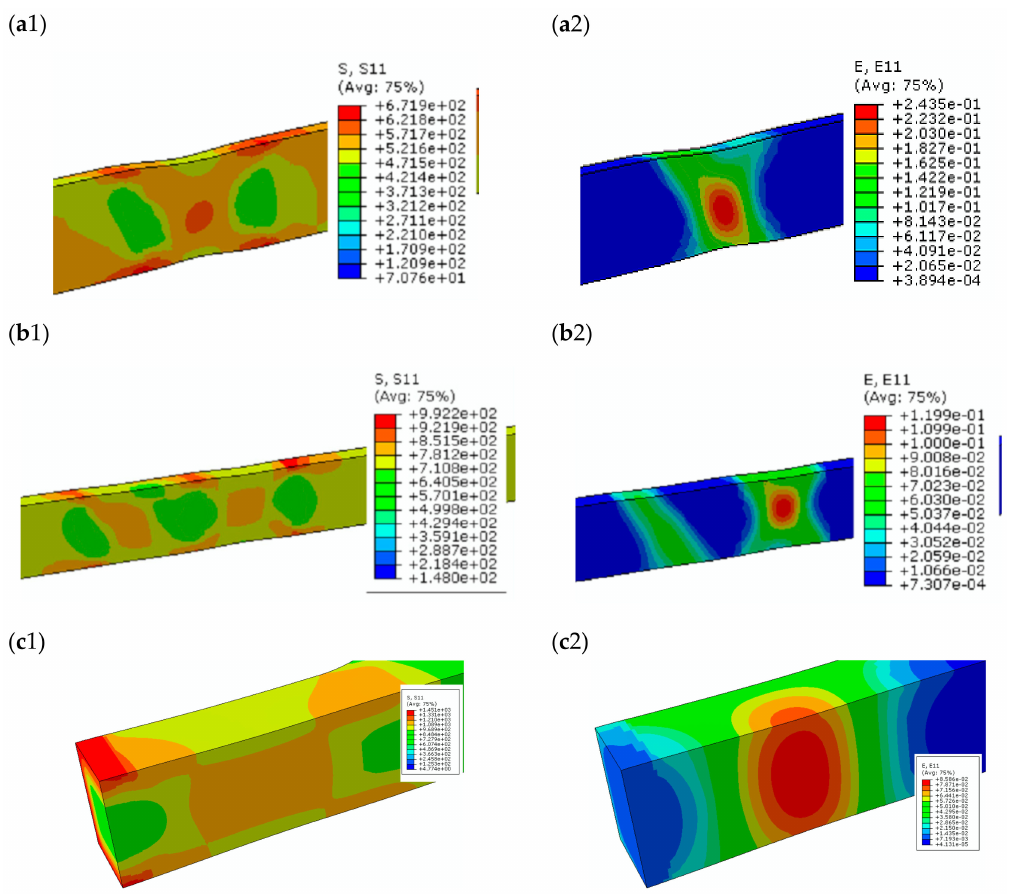
Figure 14. The fields of stresses (1) and strains (2) in middle plane of the welded joints made according to regimes: ( a ) Q 1; ( b ) Q 3; ( c ) Q